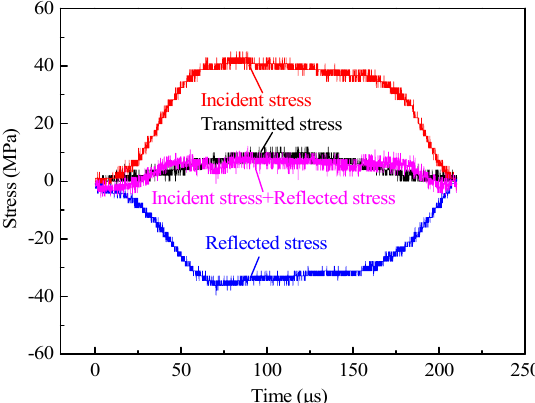
Figure 5. Stress-balance check of the split Hopkinson pressure bar (SHPB) dynamic splitting tensile tests.